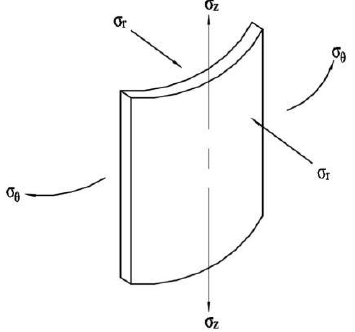
Figure 4. Triaxial stress distribution diagram of CO 2 injection string.